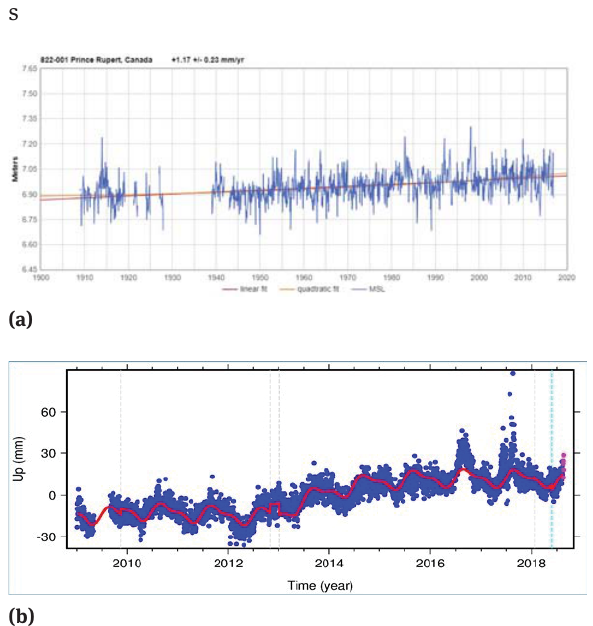
Figure 7: (a) MSL data for Prince Rupert, Canada. Image reproduced modified after [4]. (b) GNSS time series for BCPR. Image reproduced modified after NGL.